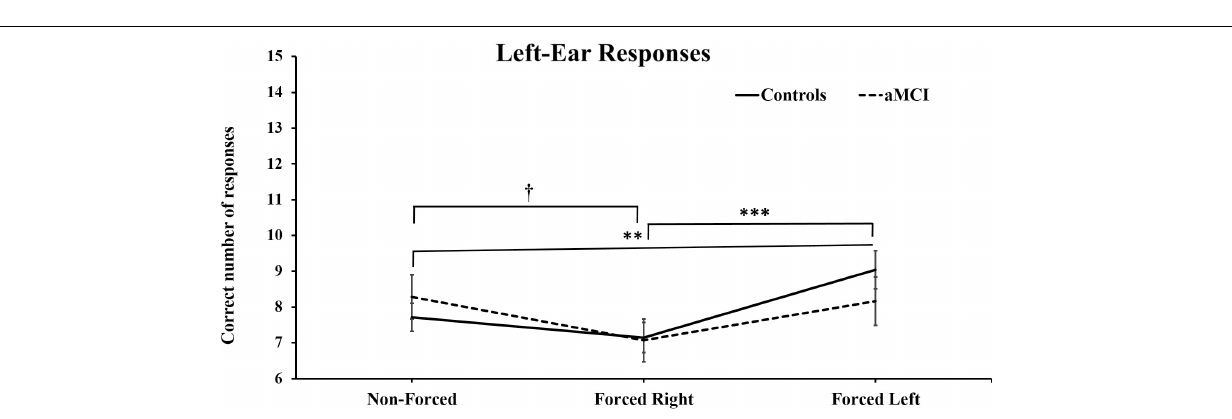
FIGURE 2 | Mean and ± SEM for correct right-ear responses across three dichotic listening conditions. aMCI, amnestic Mild Cognitive Impairment. (** p < 0.01; and *** p < 0.001) Reported significant differences are only for the control group.